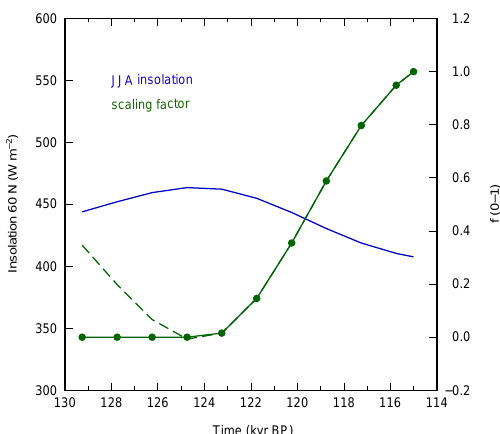
Fig. 2. The scaling factor (green) used to adjust the ECHO-G Eemian fields at the RACMO2 lateral boundaries towards glacial inception values are set proportional to the JJA (June-July-August) insolation at 60 ◦ N (blue). Dashed green line indicates values of the scaling factor if it had also been coupled to insolation in the period before